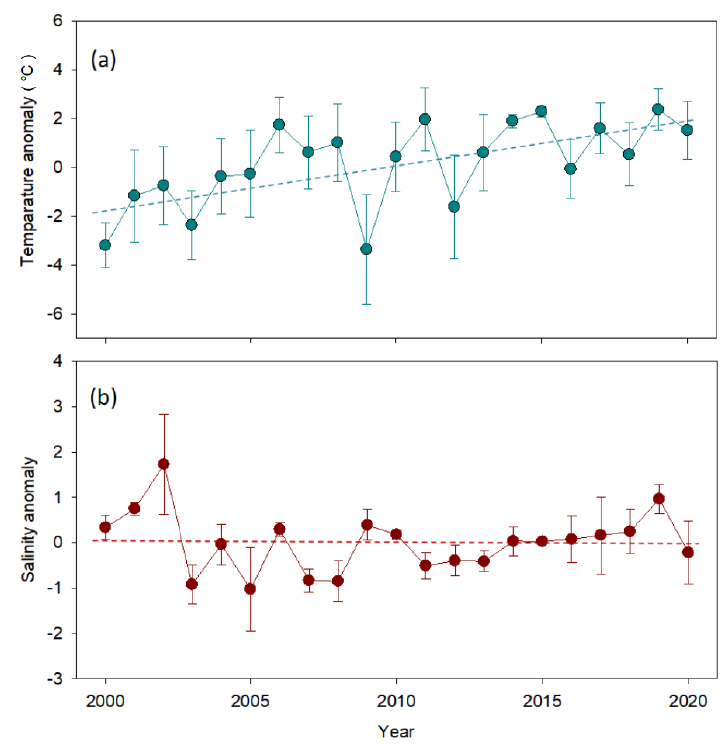
Figure 4. Anomaly of ( a ) temperature ( ◦ C) and ( b ) salinity (mean ± SD, n = 12 or 14) in November of Figure 5. Anomaly of ( a ) temperature (°C) and ( b ) salinity (mean ± SD, n = 12 or 14) in November 2000–2020 in the Jiaozhou Bay. Dashed lines indicate linear curve of 2000 – 2020 in the Jiaozhou Bay. Dashed lines indicate linear curve fits.